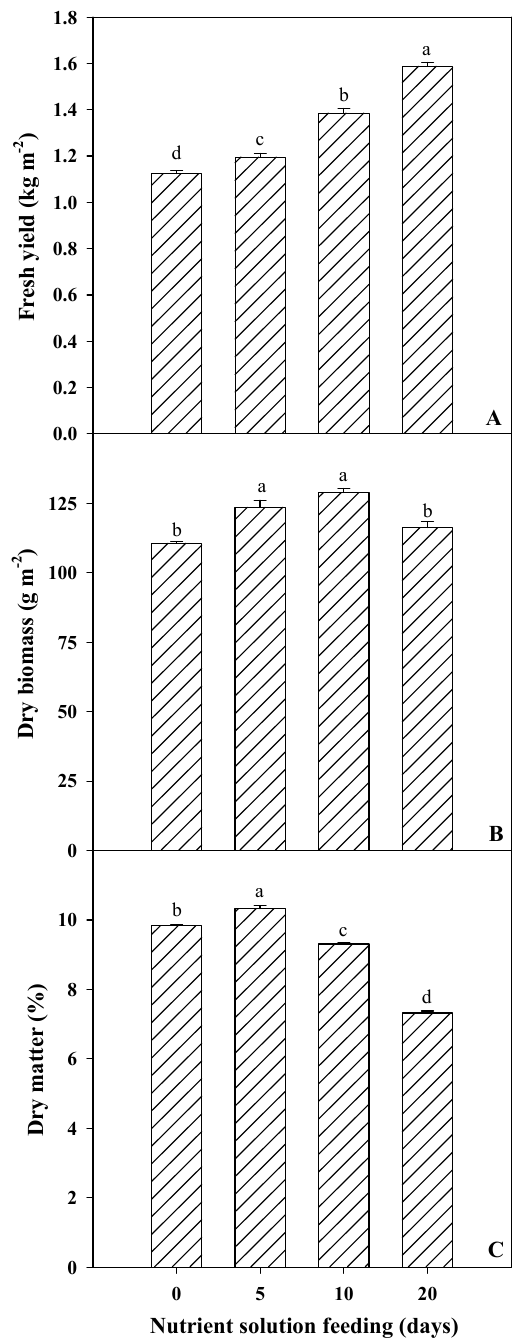
Figure 1. The effect of nutrient solution feeding (number of days) on plant growth parameters (fresh yield ( A ), dry biomass ( B ), and dry matter content ( C )). Different letters within the above bars indicate significant differences according to Duncan’s multiple range test ( p = 0.05).